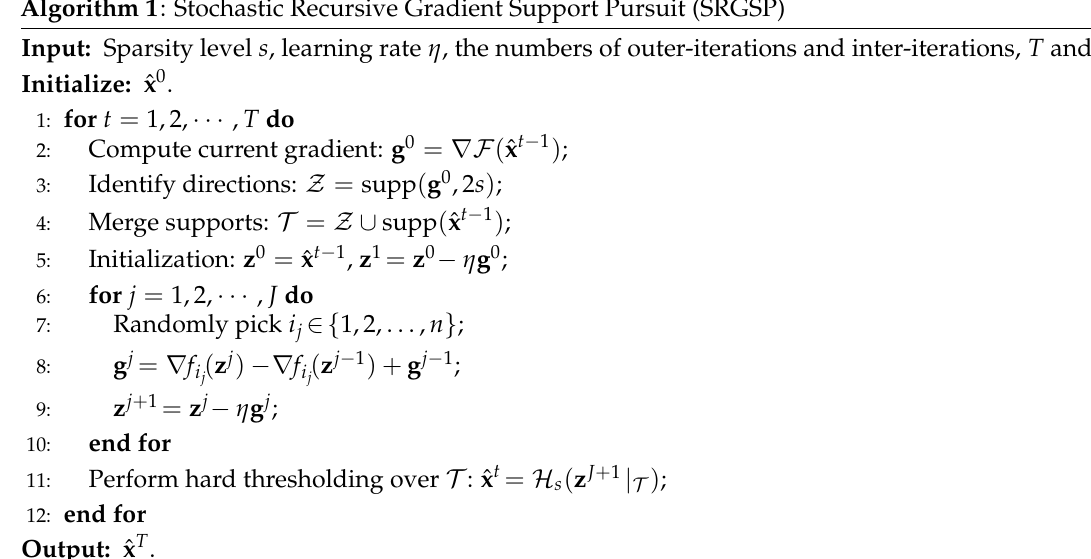
Algorithm 1 : Stochastic Recursive Gradient Support Pursuit